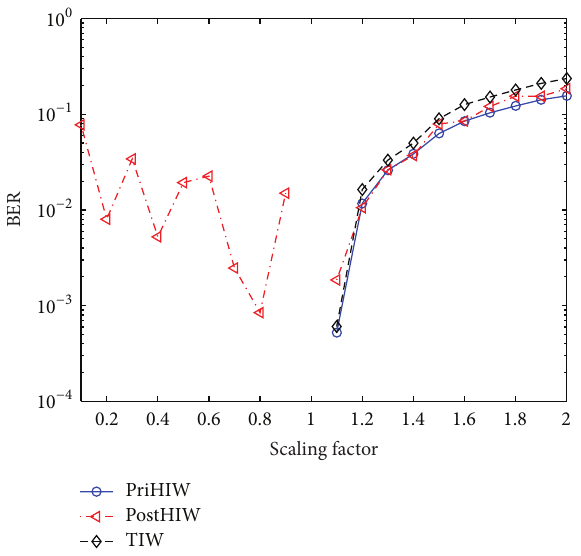
Figure 10: Performance comparison for the PriHIW, PostHIW, and TIW against gain attacks.